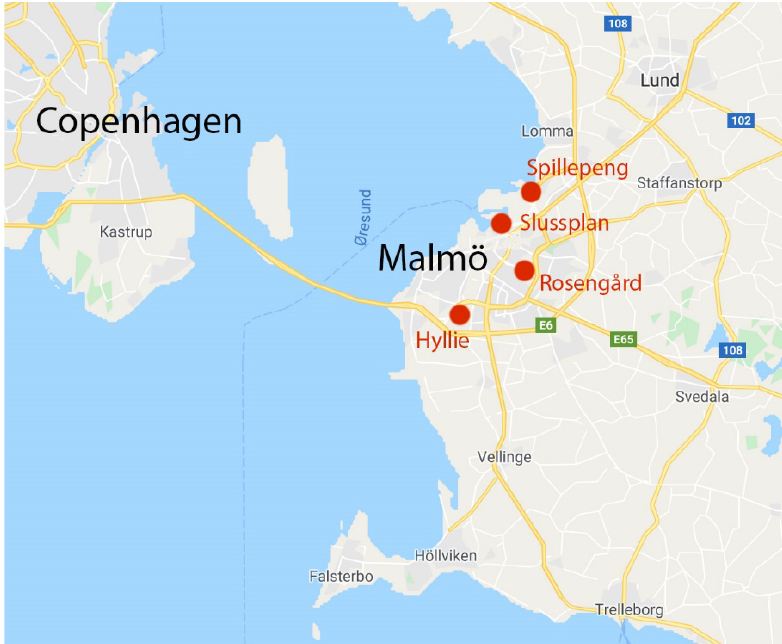
Figure 1. The location of four planning cases in Malmö. Source: Adapted from Google Maps